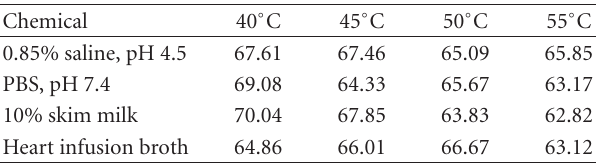
Table 5: Δ S (entropy of activation) of vaccinia virus in various solutions at 40, 45, 50 and 55 ◦ C. Values reported in Calories per mol per degree Celsius.